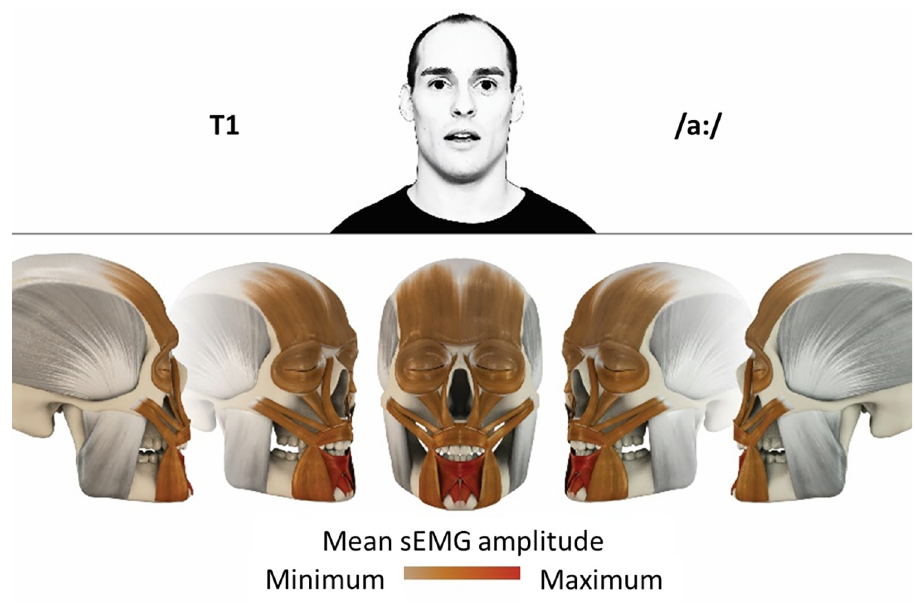
Fig 2. Color-coded facial muscle activation pattern of task T1. Pronouncing the German vowel: A/a ː /. Animation by Jonas Laustro¨er.